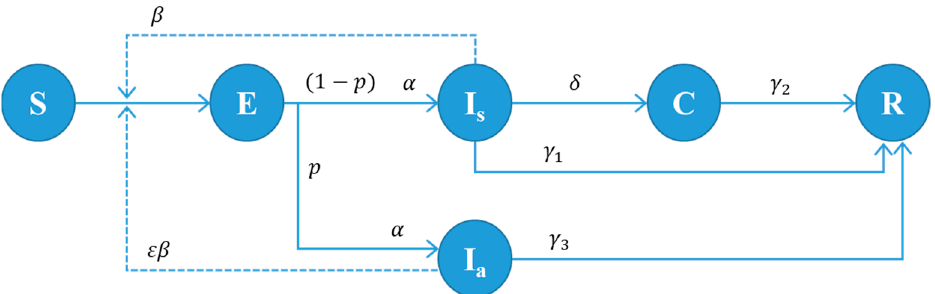
Figure 1. State transition diagram of our model. Every individual should be in one of the states, S, E, I s , I a , C, or R. The parameters in the figure are defined as follows: β : disease transmission rate of symptomatic patients. ε : relative infectiousness of asymptomatic patients. α : progression rate from state E to I a or I s (1/ α : incubation period); p : percentage of the asymptomatic case; δ : test turn-in rate (1/ δ : time between testing and result confirmation). γ 1 : recovery rate for infected but not tested individuals (1/ γ 1 : infectious period for non-tested infected patients). γ 2 : recovery rate for symptomatic and test-confirmed individuals (1/ γ 2 : isolation period for test-confirmed patients). γ 3 : recovery rate for asymptomatic individuals (1/ γ 3 : infectious period for asymptomatic